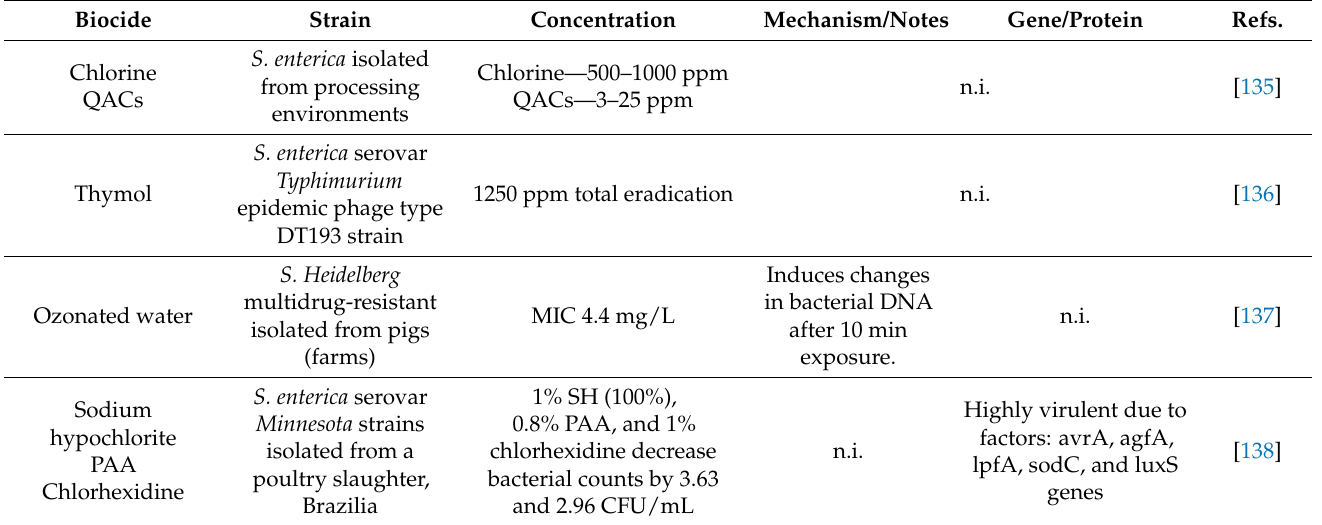
Table 7. Biocides and their impact on Salmonella